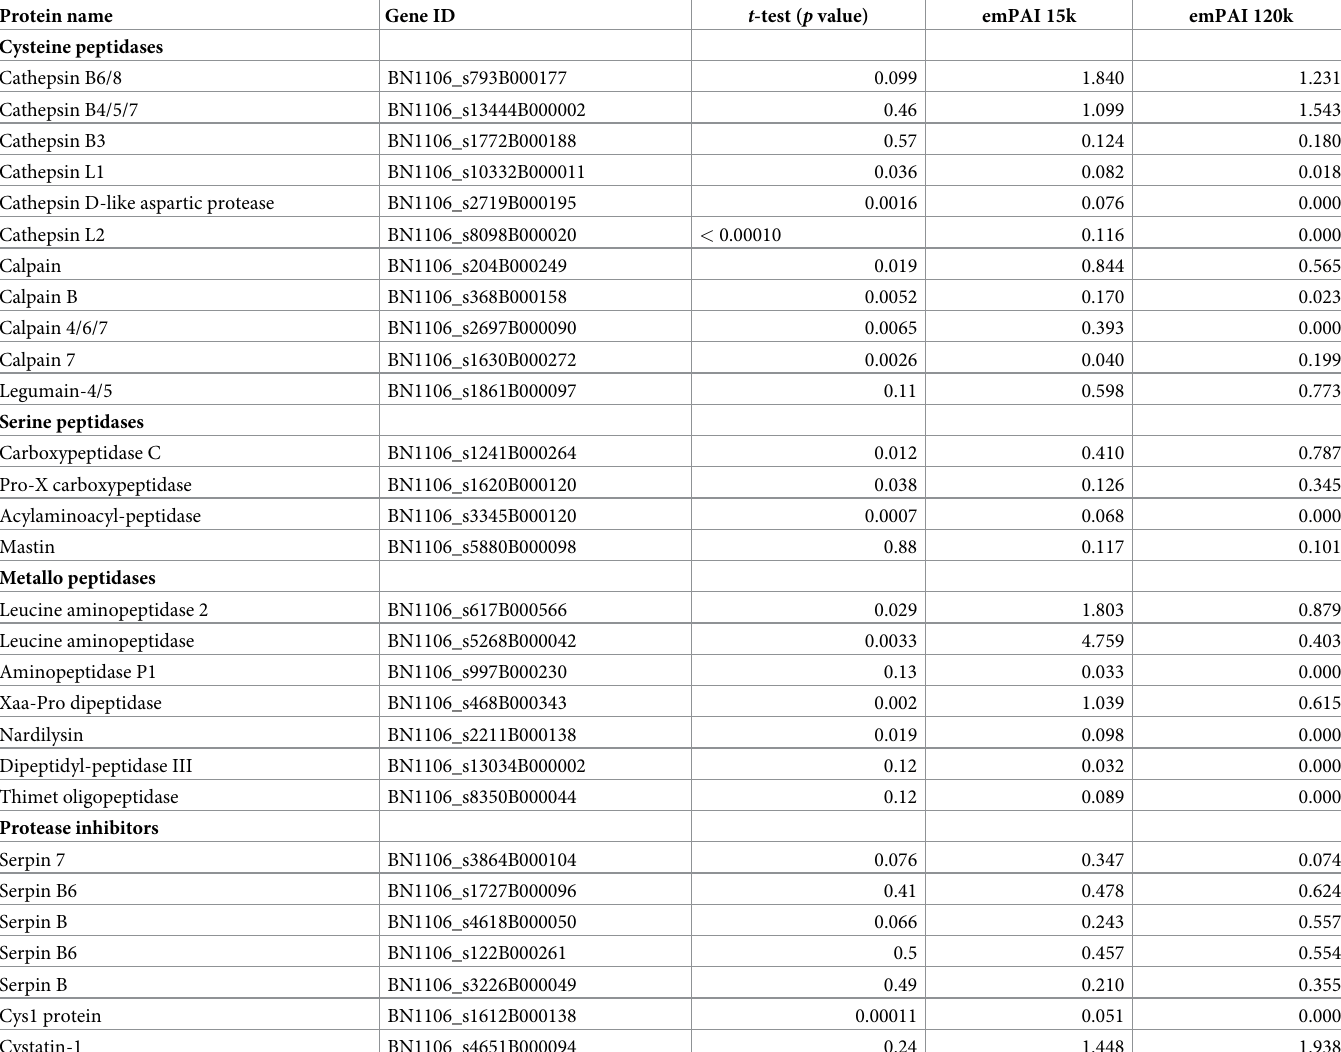
Table 2. Proteases and protease inhibitors found on the surface of F . hepatica